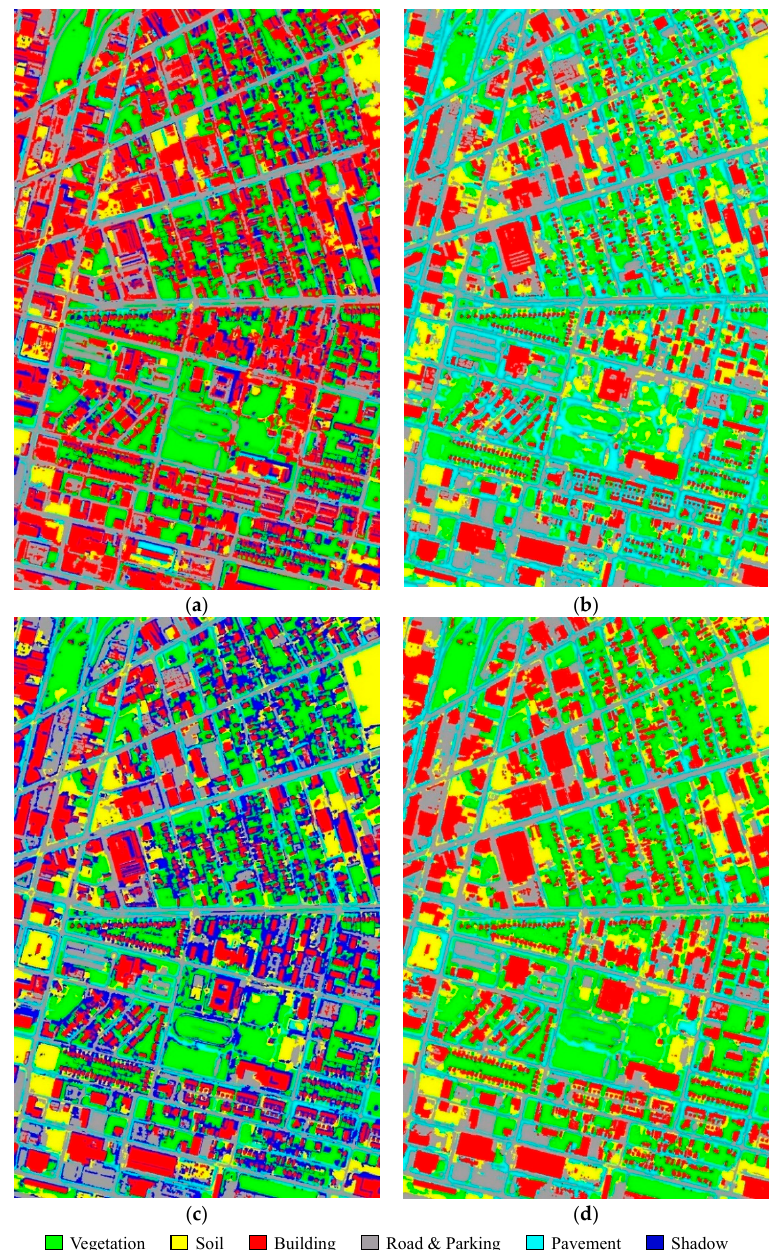
Figure 16. ( a ) Independent classification map of high-resolution image, ( b ) independent classification map of LiDAR data, ( c ) joint classification map using LIDAR data and high-resolution image, and ( d ) classification map following object-based post-classification fusion (the proposed method).